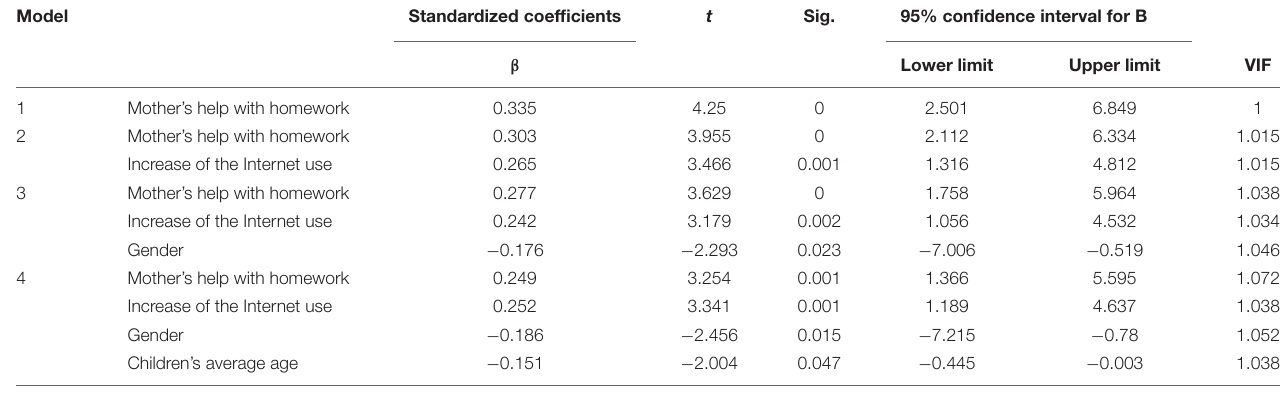
TABLE 3 | Regression model for predicting cognitive anxiety.